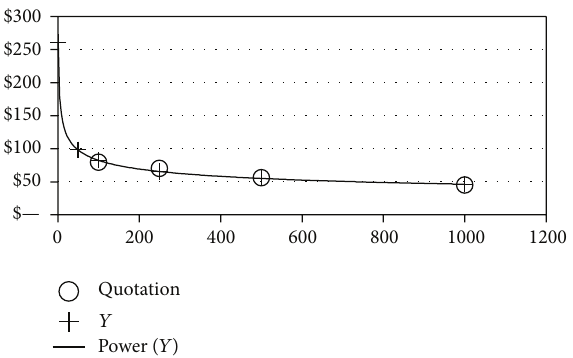
Figure 7: Graph of quotation price versus learning model price for pressure